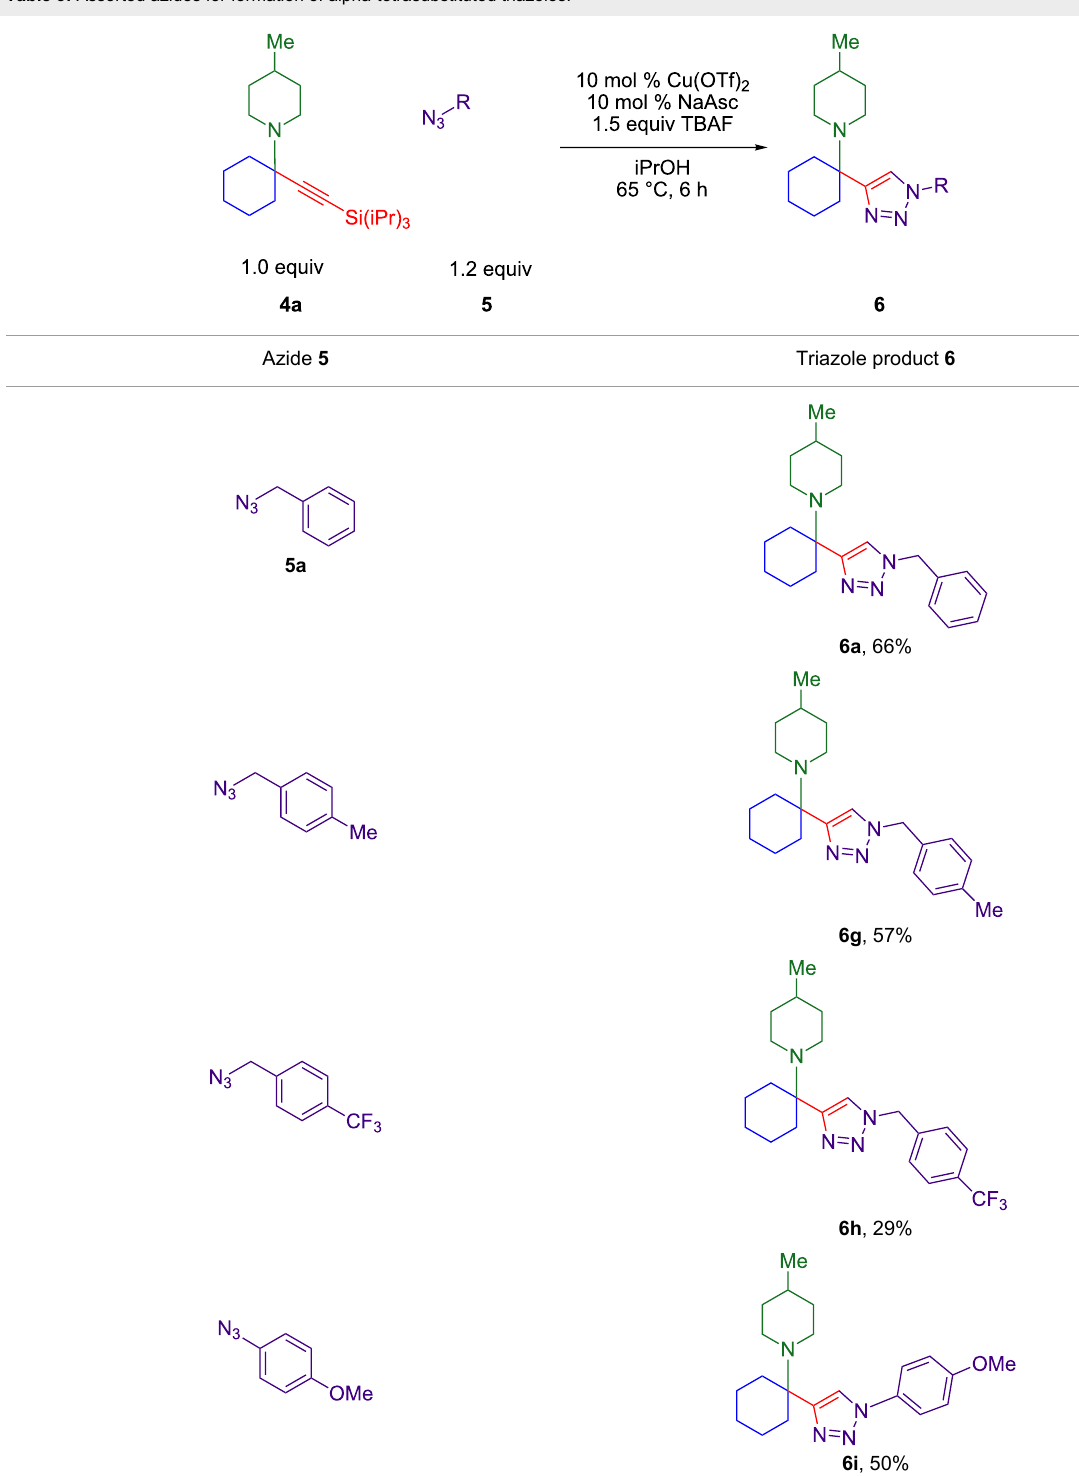
Table 3: Assorted azides for formation of alpha-tetrasubstituted